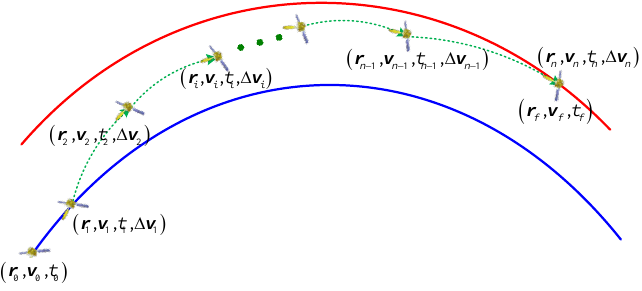
Figure 2. The multi-impulse pursuit trajectory for the far-distance rendezvous stage. Different from the traditional rendezvous mission trajectory, the pursuit trajectory of the FRS terminates when it reaches the perception range of the evader. Therefore, the maneuvers planned in the perception range of the evader are not actually